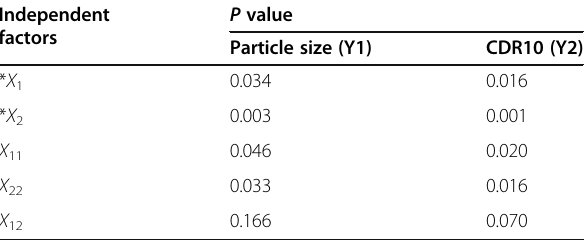
Table 3 Statistical analysis of particle size and CDR10 Independent P value factors